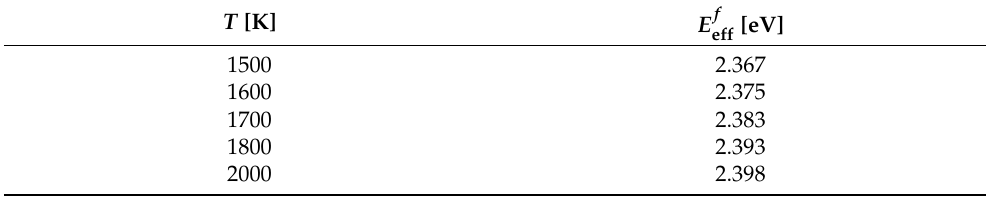
Table 4. The effective vacancy formation energies of Nb-Mo-Ta-W at different